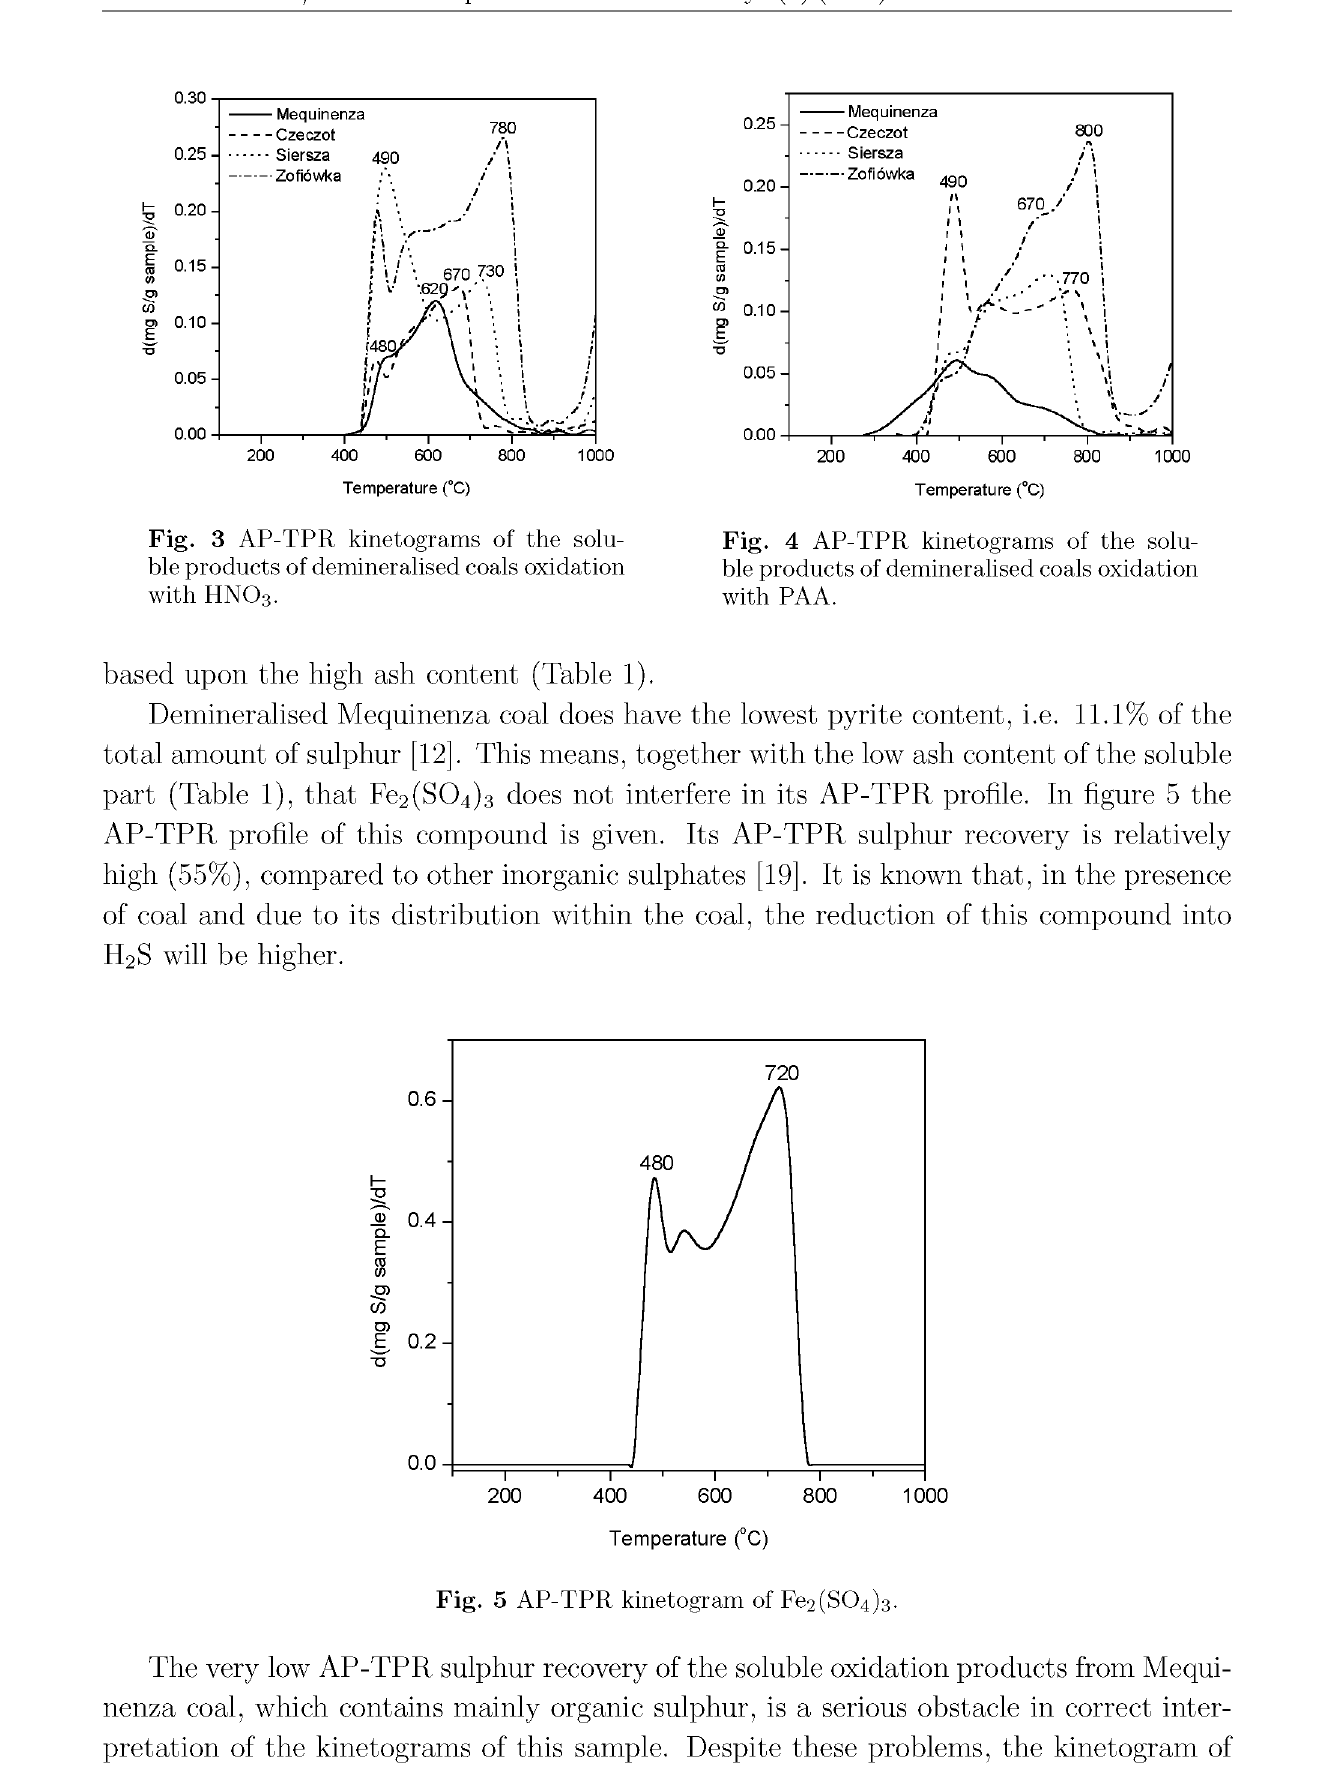
Fig. 5 AP-TPR kinetogram of